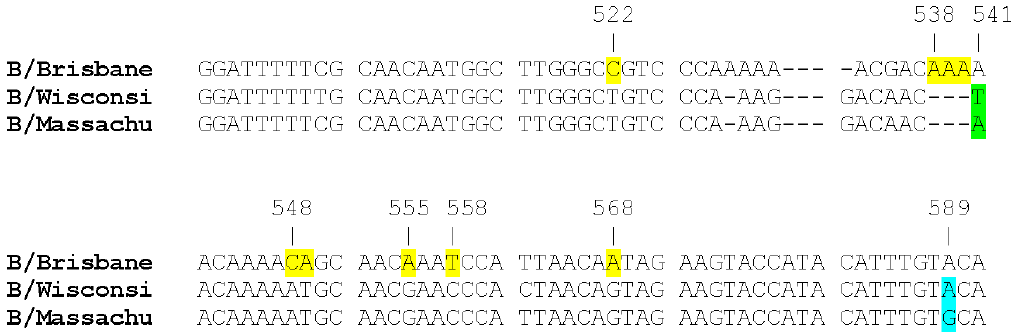
Figure 1. Nucleotide changes distinguishing the influenza B viruses of the